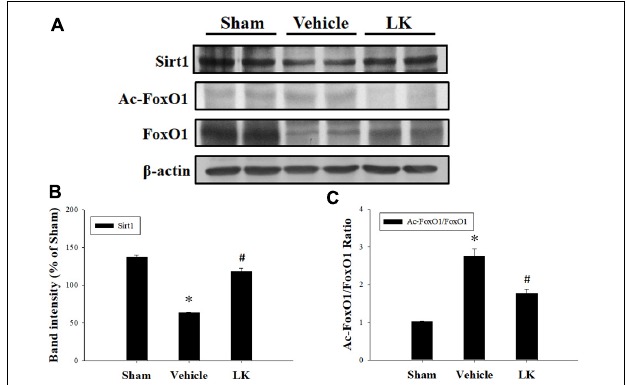
FIGURE 2 | Post-ischemic lumbrokinase treatment activated Sirt1 after myocardial I-R injury. Post-ischemic treatment with vehicle or lumbrokinase (10 µ g/kg) in rats subjected to myocardial I-R injury. (A) Representative images of the Western blot results. Quantitative densitometric analysis of (B) Sirt1 protein expression and (C) the ratio of Ac-FoxO1 to FoxO1 in rat myocardium after myocardial I-R injury. Data are normalized with values from the sham group and presented as percentage rates. Each value is represented as the mean ± SEM ( n = 3). ∗ p < 0.05 compared with the sham group; # p < 0.05 compared with the vehicle group.